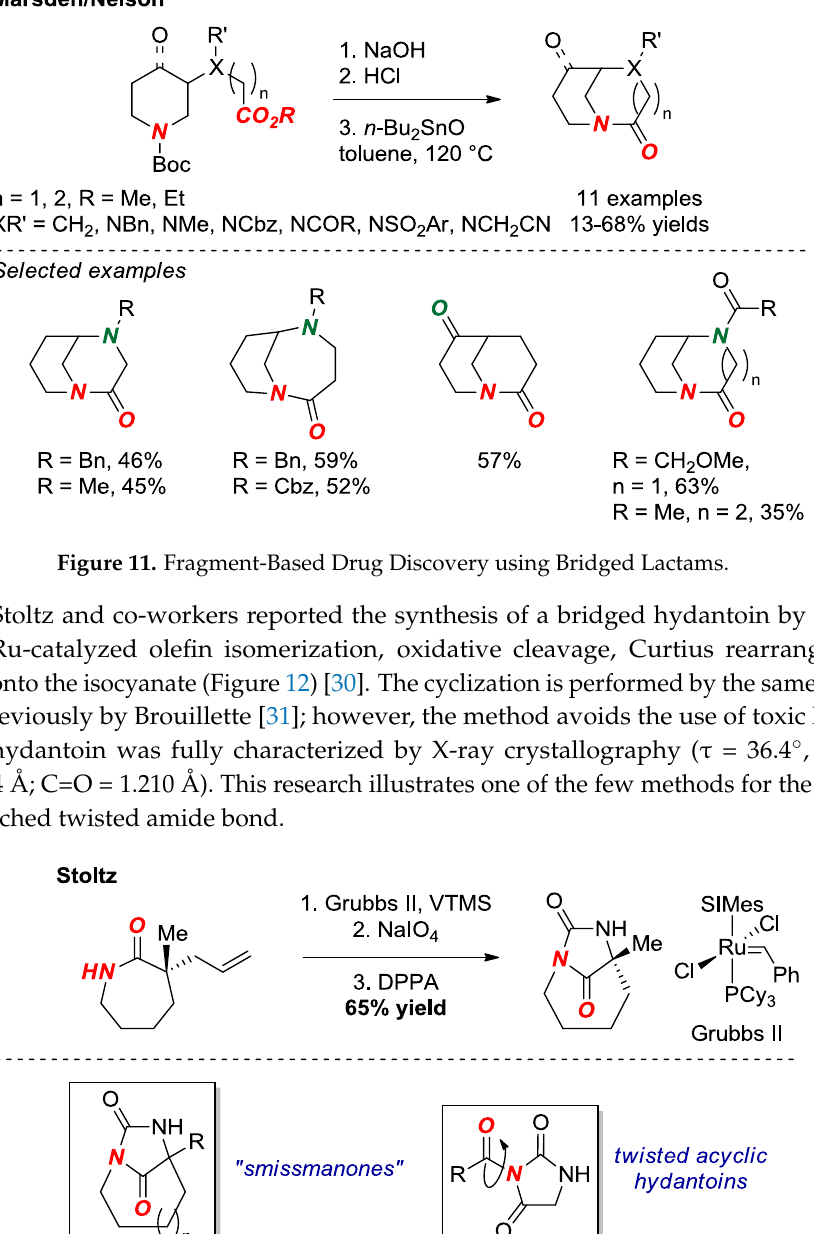
Figure 12. Synthesis of a Bridged Hydantoin. VTMS = Vinyloxytrimethylsilane. DPPA = diphenyl phosphoryl azide. SIMes = 1,3-Bis(2,4,6-trimethylphenyl)-2-imidazolidinylidene.